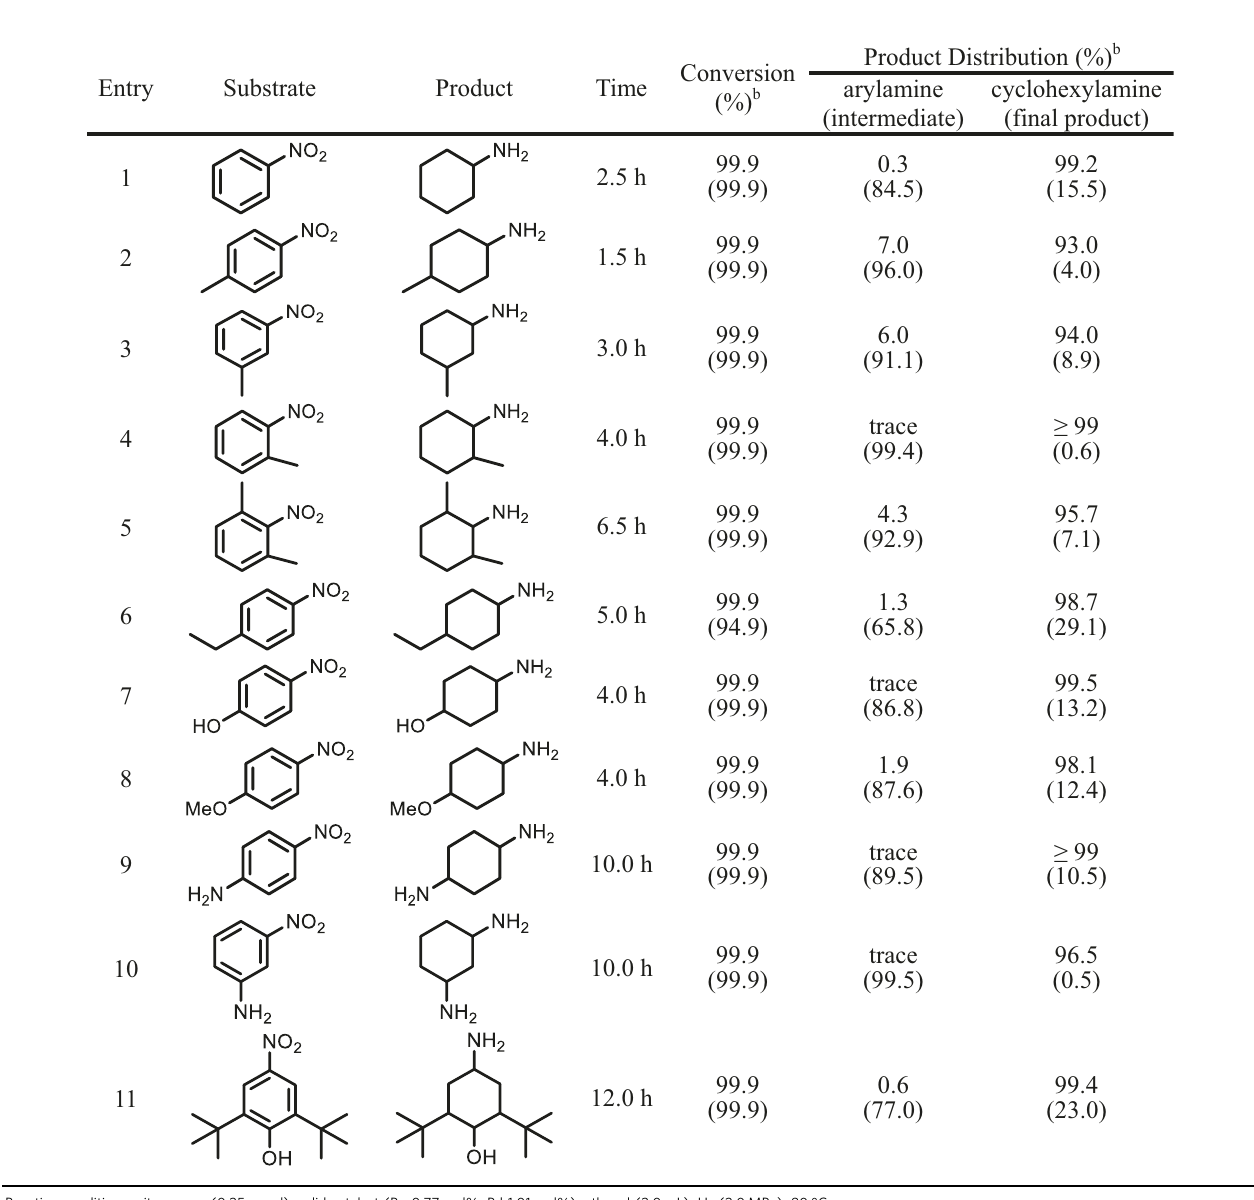
Table 1 Results of sequential hydrogenation of various nitroarenes over the Ru/Pd/MCMOS cascade catalyst and the physically mixed catalyst a